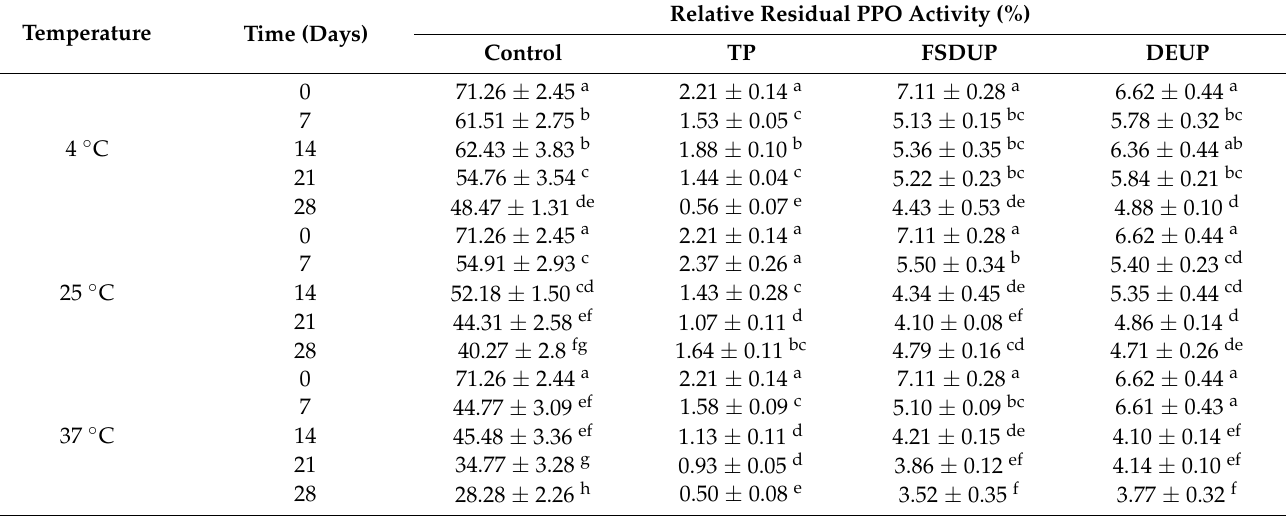
Table 2. Changes in PPO activity in strawberry clear juice during storage after thermal pretreatment and multi-mode